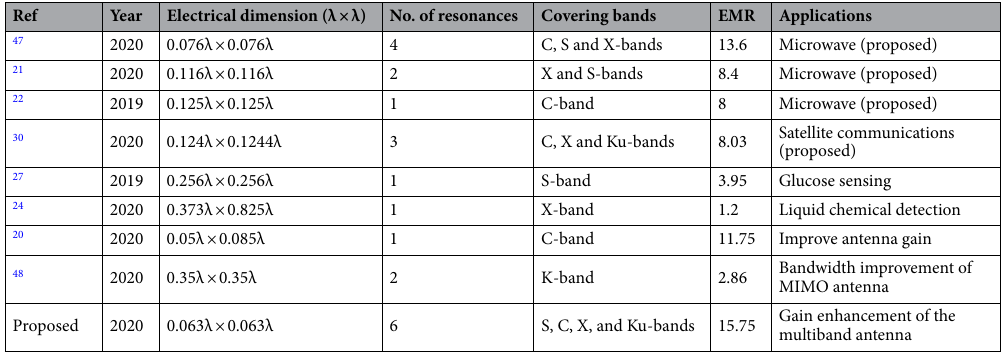
Table 6. Performance comparison of proposed MTM with other states of the art based on number of resonances, covering band, EMR, and applications.